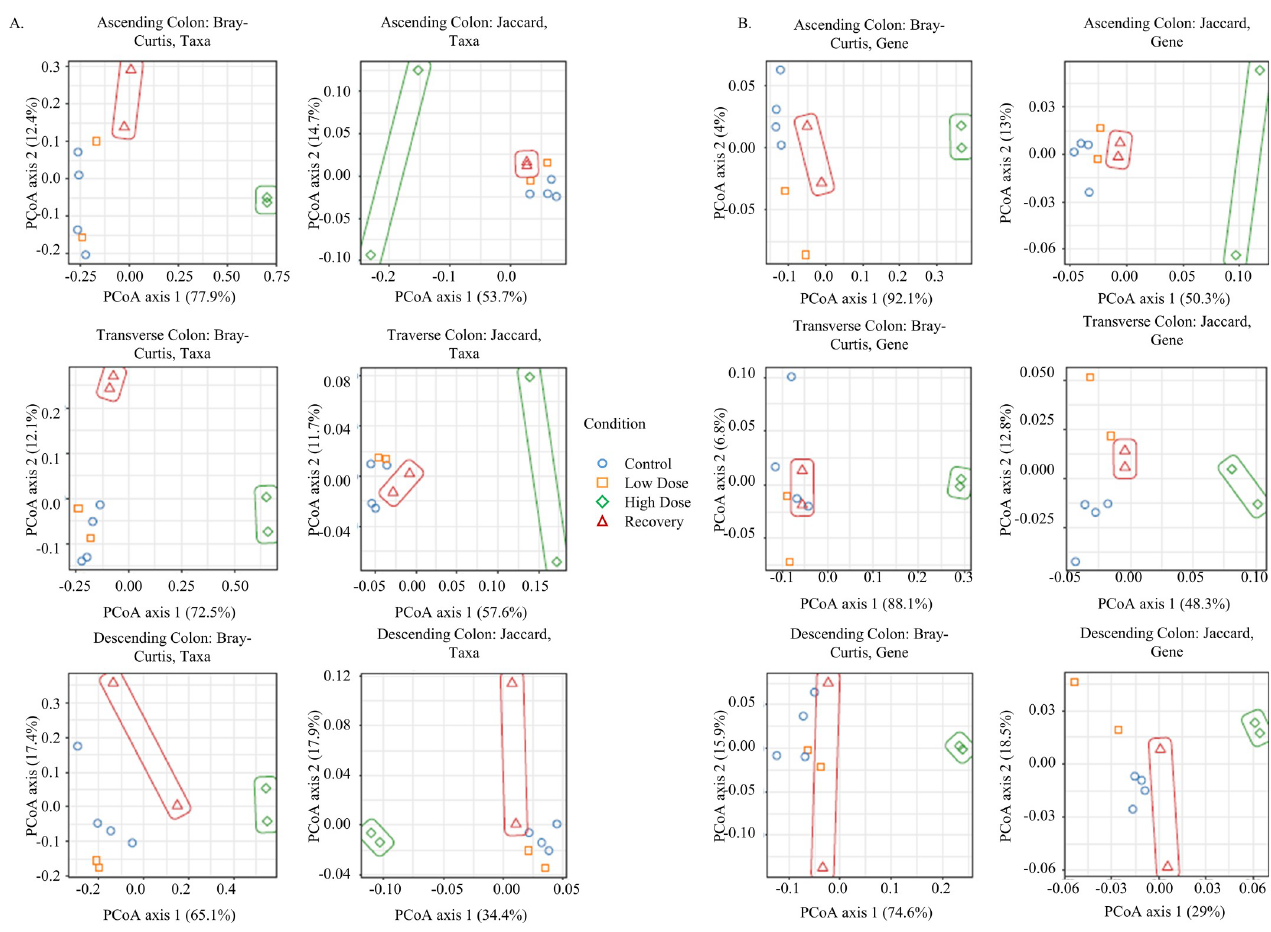
Fig 5. Gene analysis from shotgun sequencing. A) Taxa based PCoA plots. Bray-Curtis (left) is based on the proportion/composition of the taxa. Jaccard distance (right) is based on the presence/absence of the taxa B) Beta diversity based on KEGG Ortholog (KO) composition, meaning the presence/absence of gene function is used to measure the Bray-Curtis